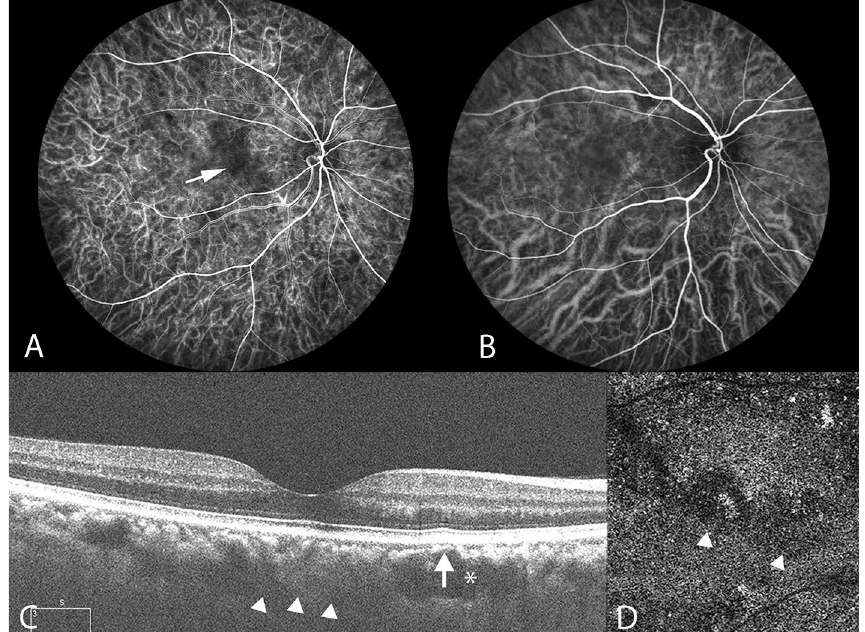
Figure 1. Multimodal imaging of the right eye of a 45-year-old man with chronic central serous chorioretinopathy. Pachyvessels and attenuation of the inner choroid are seen. ( A ) Indocyanine green video with underlying pachyvessels ( B ) and choriocapillaris attenuation ( D ). ( B ) ICGA image indicating dilated choroidal vessels near the macula. Pachyvessels are shown as dilated choroidal vessels that do not taper